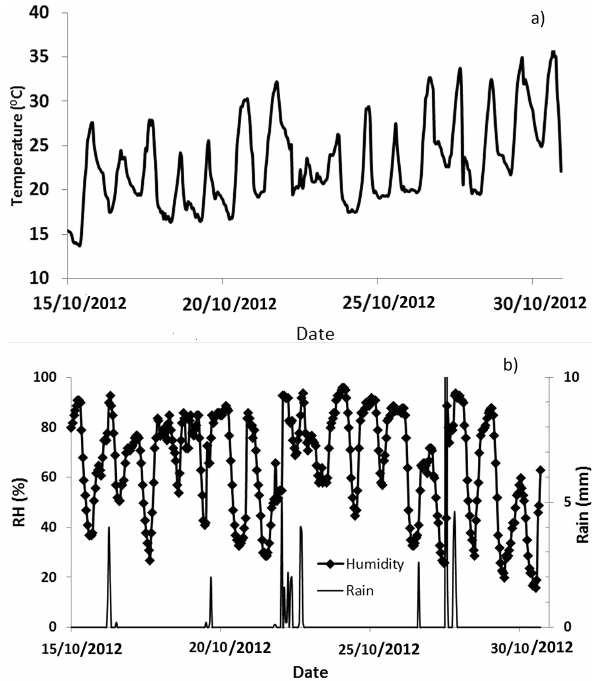
Figure 1. Time series of the (a) temperature and (b) RH and pre- cipitation at the sampling site during the studied